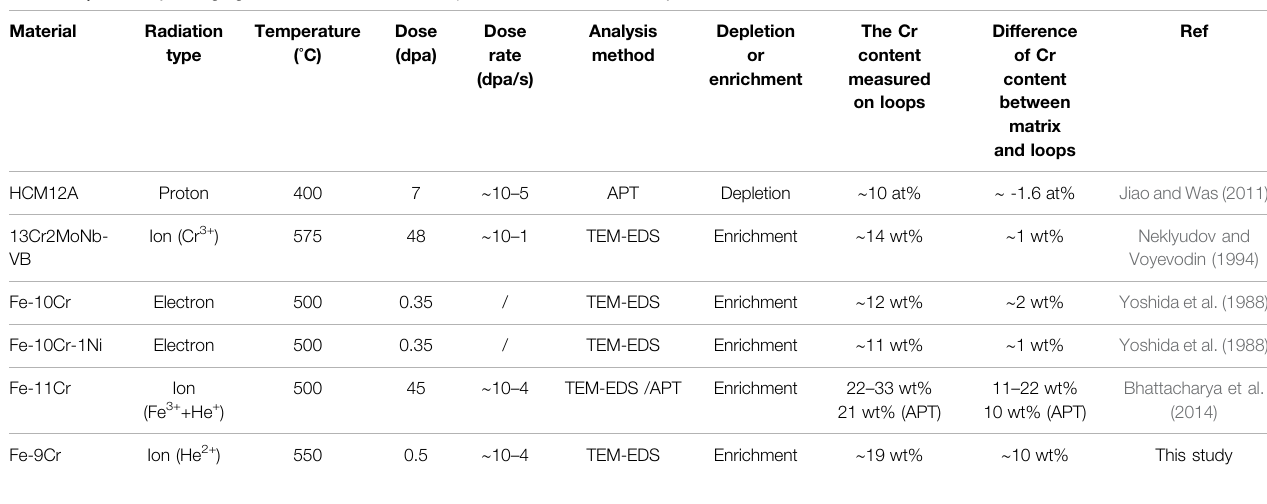
TABLE 5 | Summary of segregation of Cr at dislocation loops in literature and this